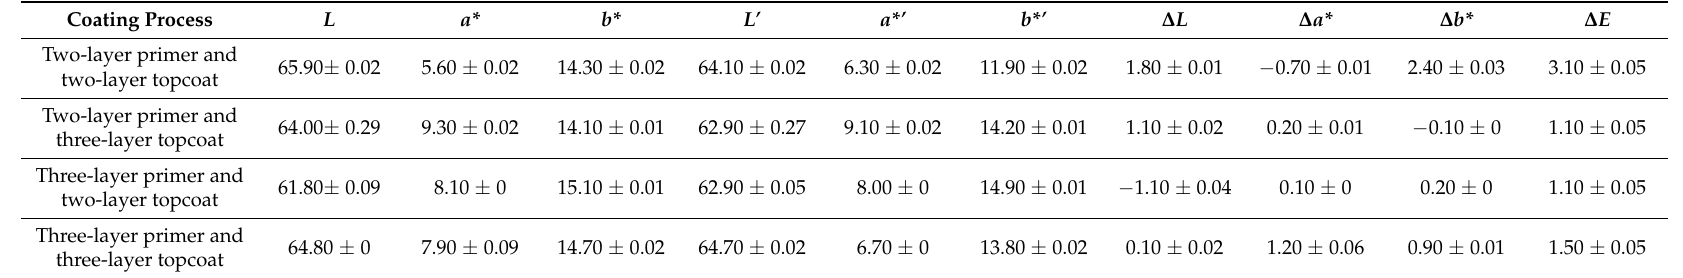
Table 4. Effect of microcapsules in topcoat on color difference of waterborne